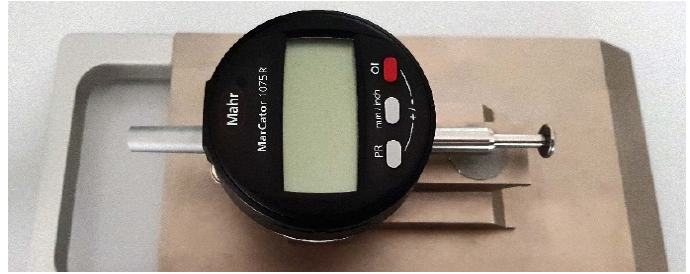
Figure 5. Instrumented Charpy pendulum used to conduct the tests.